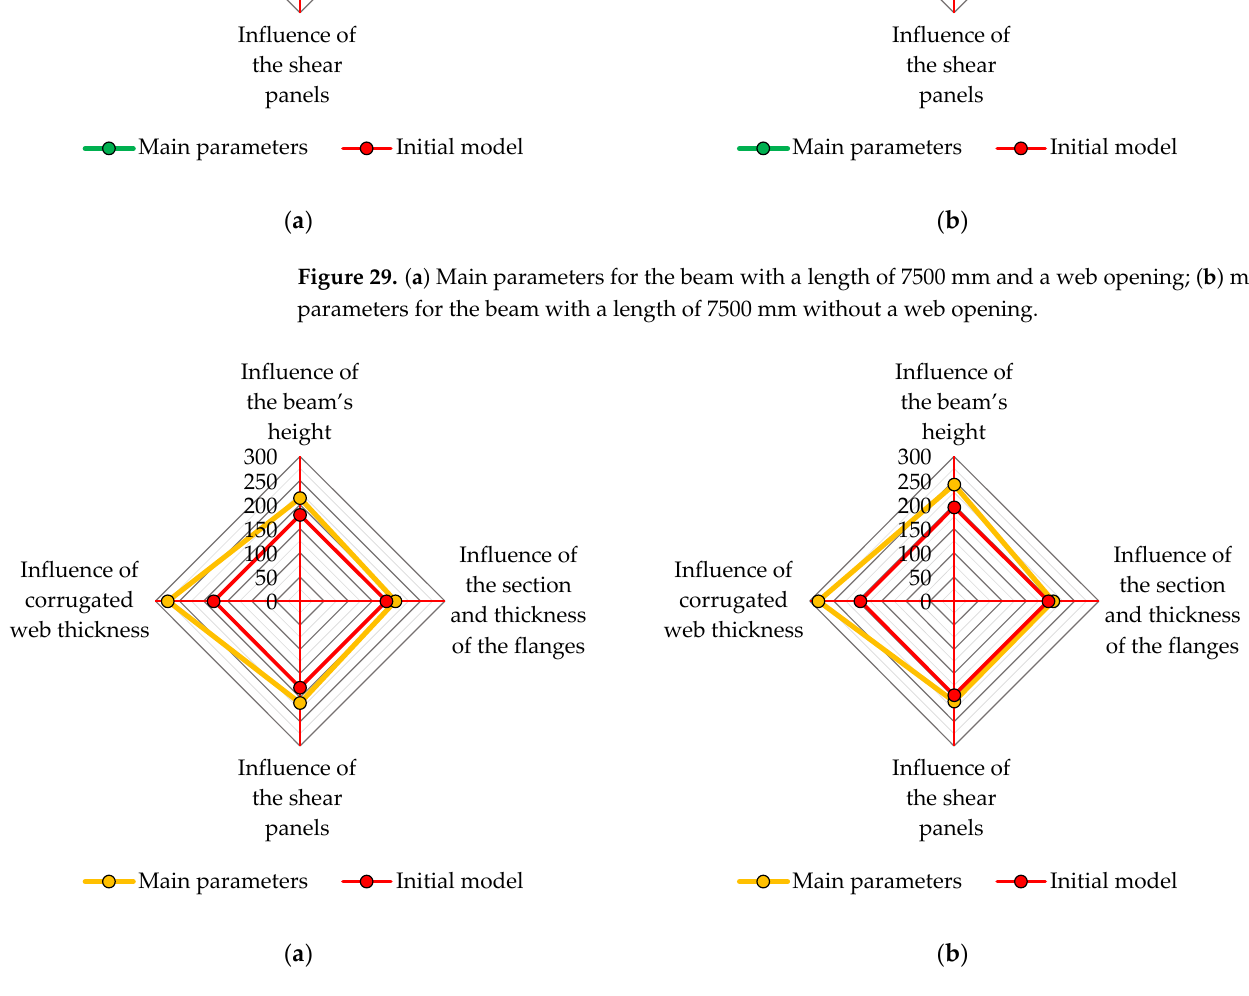
Figure 30. ( a ) Main parameters for the beam with a length of 9000 mm and a web opening; ( b ) main parameters for the beam with a length of 9000 mm without a web opening.